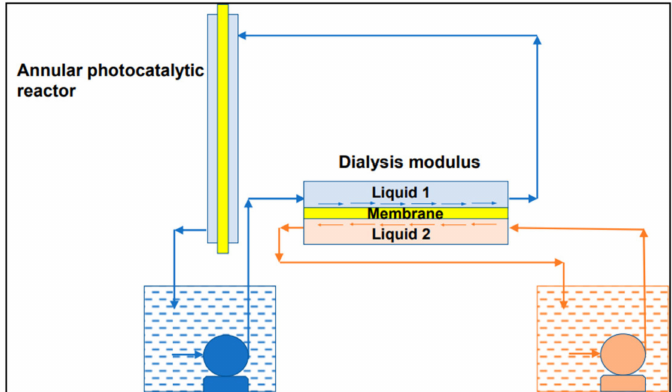
Figure 15. Scheme of the experimental set-up obtained by continuously recirculating the reacting solution (Liquid 1) through the photocatalytic reactor and the membrane modulus. Reprinted with permission from ref. [59]. Copyright © 2021